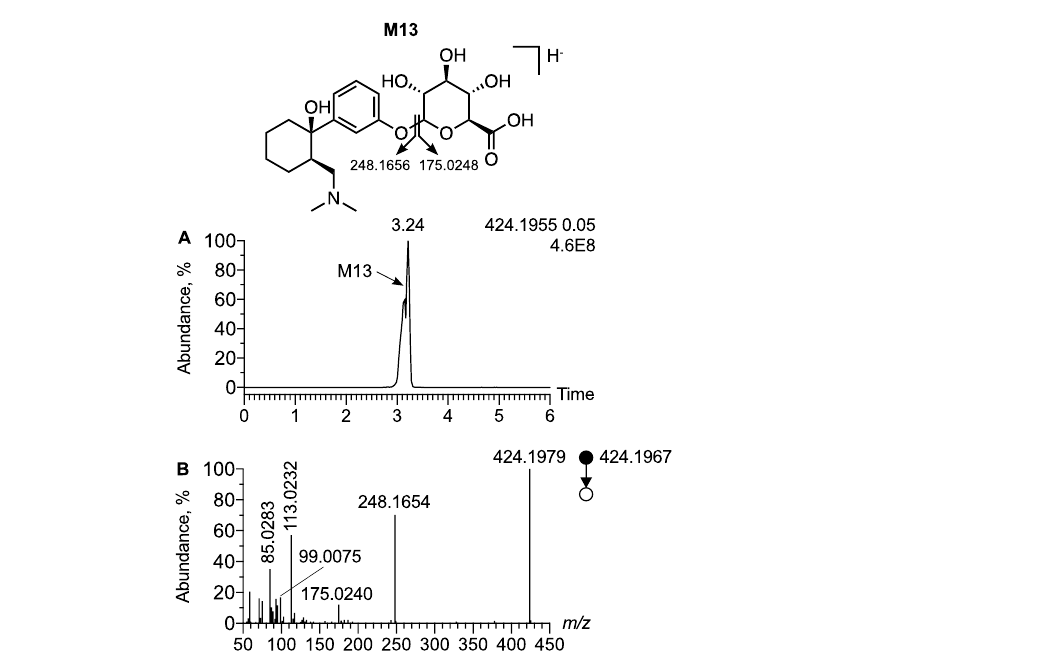
Figure 5. Analytical features of O-desmethyl tramadol glucuronide in negative ion mode. ( A ) Extracted ion chromatogram of urine extract at m / z 424.1955 corresponding to the [M-H] - ion of desmethyl tramadol glucuronide. ( B ) MS/MS spectra of [M-H] - ion of desmethyl tramadol.